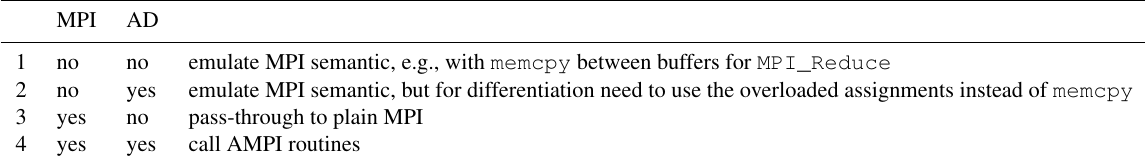
Table 1. Logic variants encapsulated in the ISSM MPI wrapper